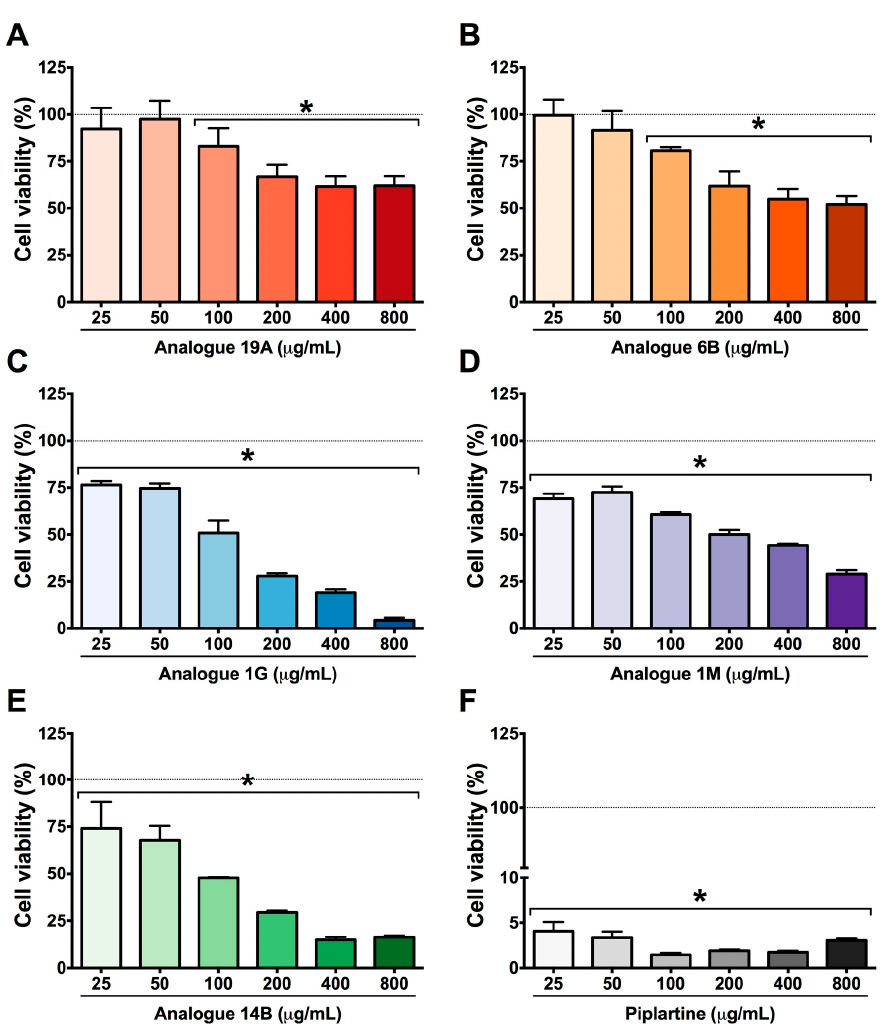
Figure 3. Cytotoxicity evaluation using the MTT method in murine fibroblast (NIH3T3) cells after exposure for 24 h to piplartine analogues ( A ) 19A (72–2331 µ M), ( B ) 6B (62–1998 µ M), ( C ) 1G (85–2738 µ M), ( D ) 1M (56–1796 µ M), ( E ) 14B (101–3250 µ M) and ( F ) piplartine (78–2514 µ M). Molecules were used at the same concentrations range at µ g/mL for all samples (25–800). Dimethyl sulfoxide (DMSO) was used as a negative control. The values are expressed as mean ± SEM. * p < 0.05 vs. DMSO control group. The dotted lines mark the 100% viability level.